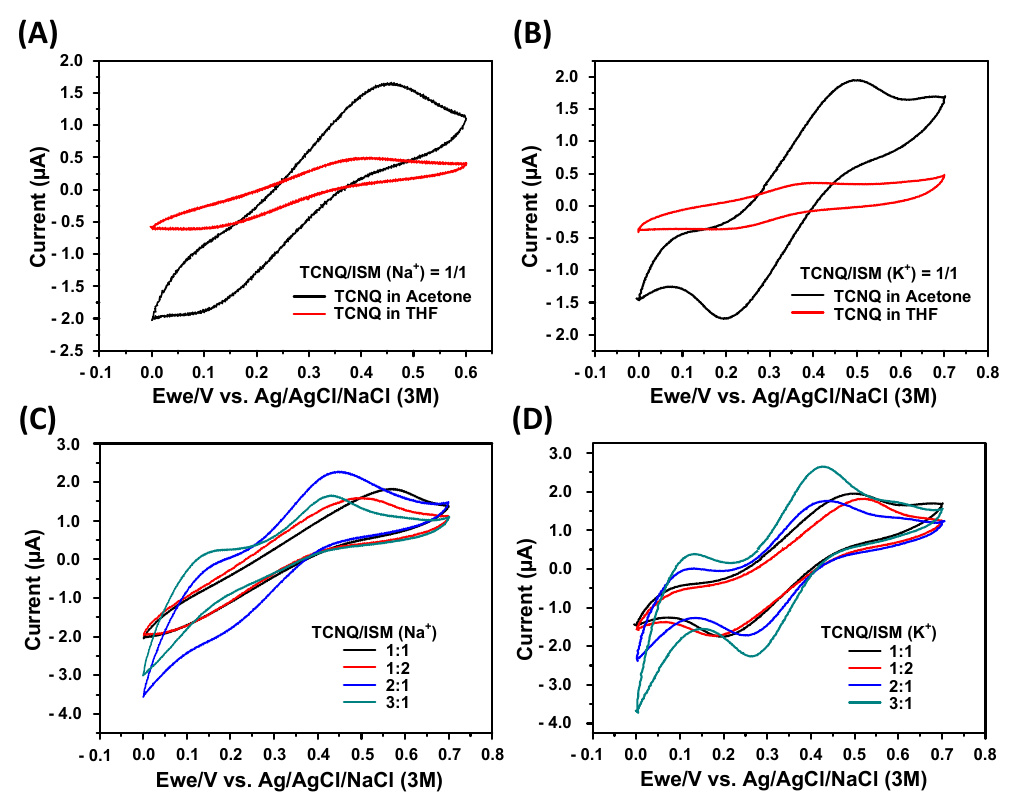
Figure 2 . Cyclic voltammograms for TCNQ solvent selection and TCNQ/ISM volume ratio optimization: ( A , B ) cyclic voltammograms for Na + (140 mM NaCl) and K + (5 mM KCl) detections, respectively; ( C , D ) cyclic voltammograms for Na + and K + detections with different TCNQ/ISM volume ratios, respectively.